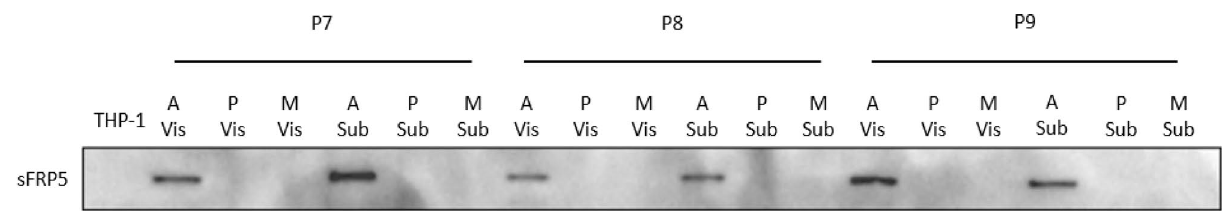
Figure 3. Investigation of sFRP5 expression in different cell types of the adipose tissue study cohort: Western blot: sFRP5 expression was analysed in THP-1 control, visceral and subcutaneous adipocytes, pre-adipocytes and macrophages from three representative samples (patient P7, P8, P9). Only visceral and subcutaneous adipocytes showed sFRP5